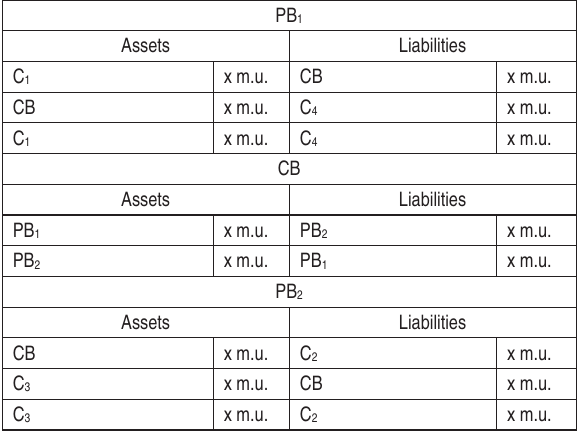
Table 2. The ‘internalization’ of interbank